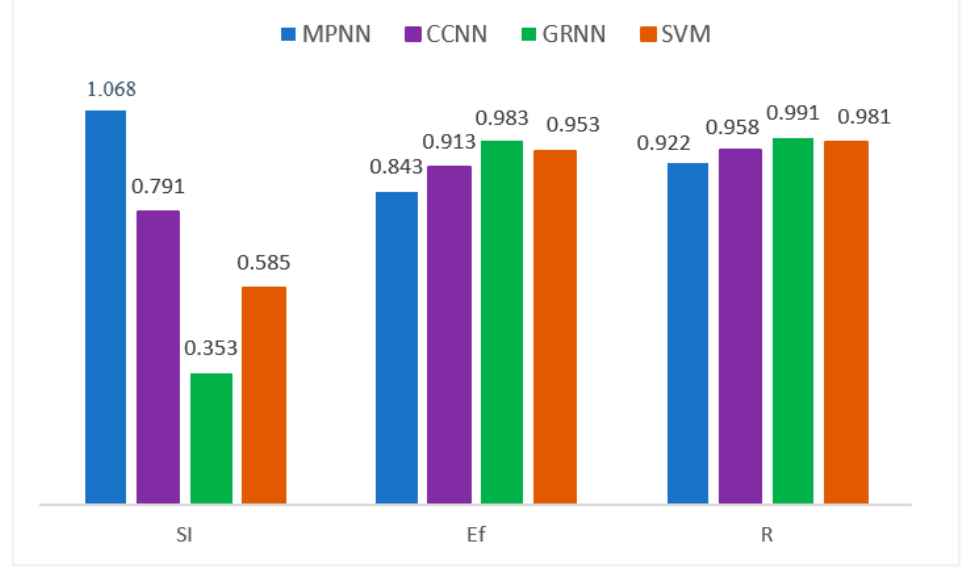
Figure 11. Comparison of the different ANN and SVM models.